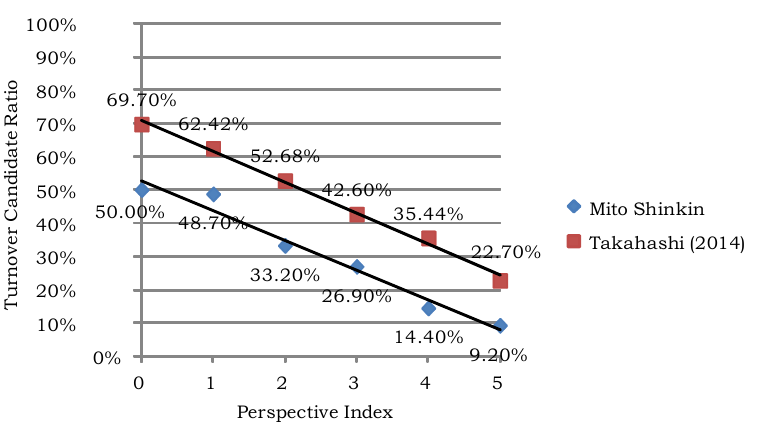
Figure 2. Perspective index and turnover candidate